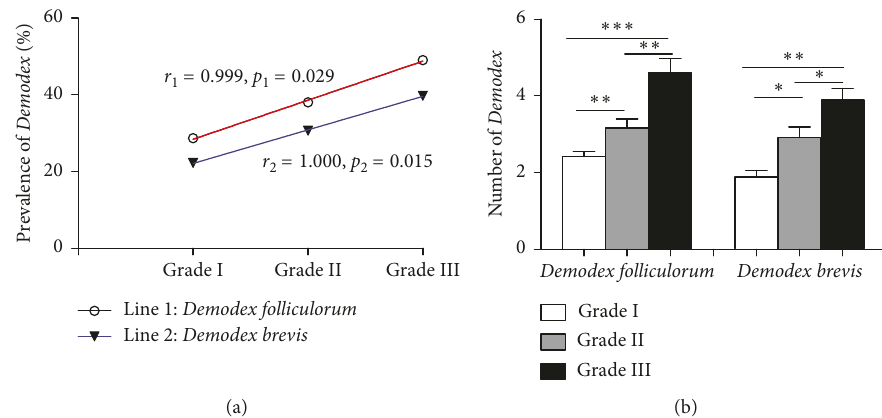
Figure 4: (a) The relationship between congestion severity and the number of Demodex in the CD group. (b) In the CD group, the number of Demodex folliculorum and Demodex brevis was highest in Grade III cases and the lowest in Grade I